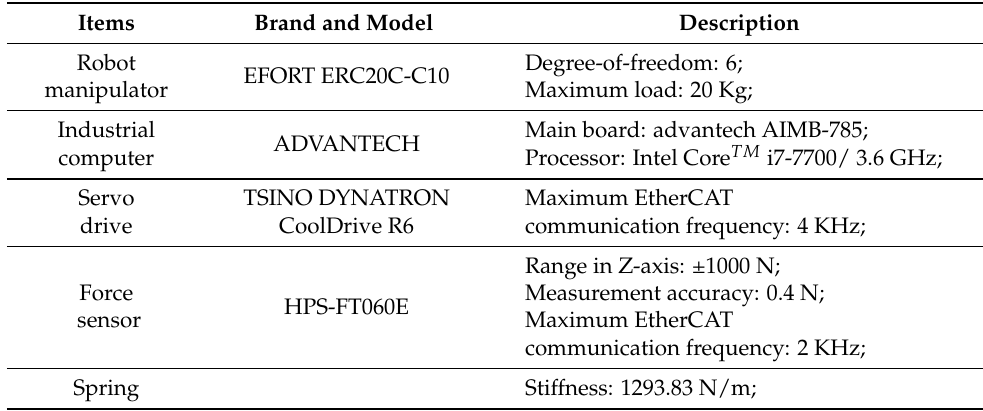
Figure 14. Experimental setup. Table 6. Experimental setup description and parameters.